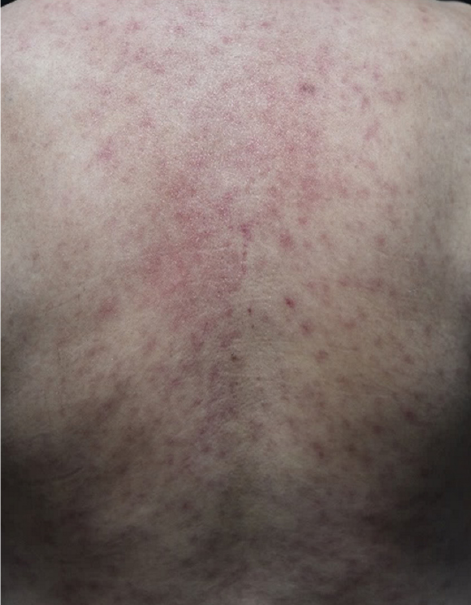
Figure 1. Maculopapular eruption. Diffuse, asymptomatic, erythematous maculopapular rash on the trunk and four extremities in a patient with hepatocellular carcinoma who started atezolizumab treatment 15 days